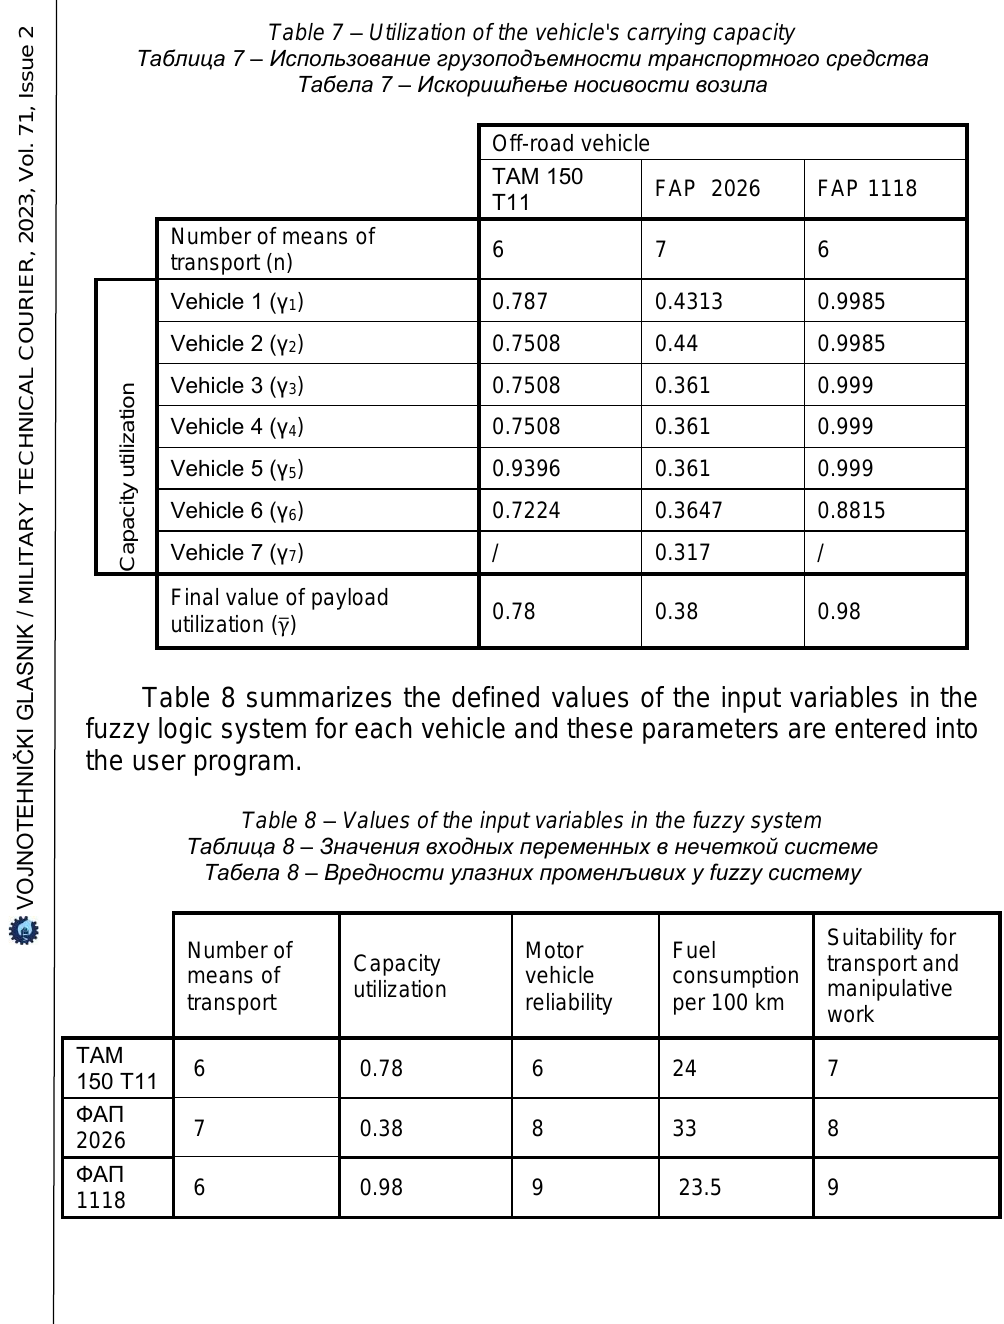
Table 7 – Utilization of the vehicle's carrying capacity